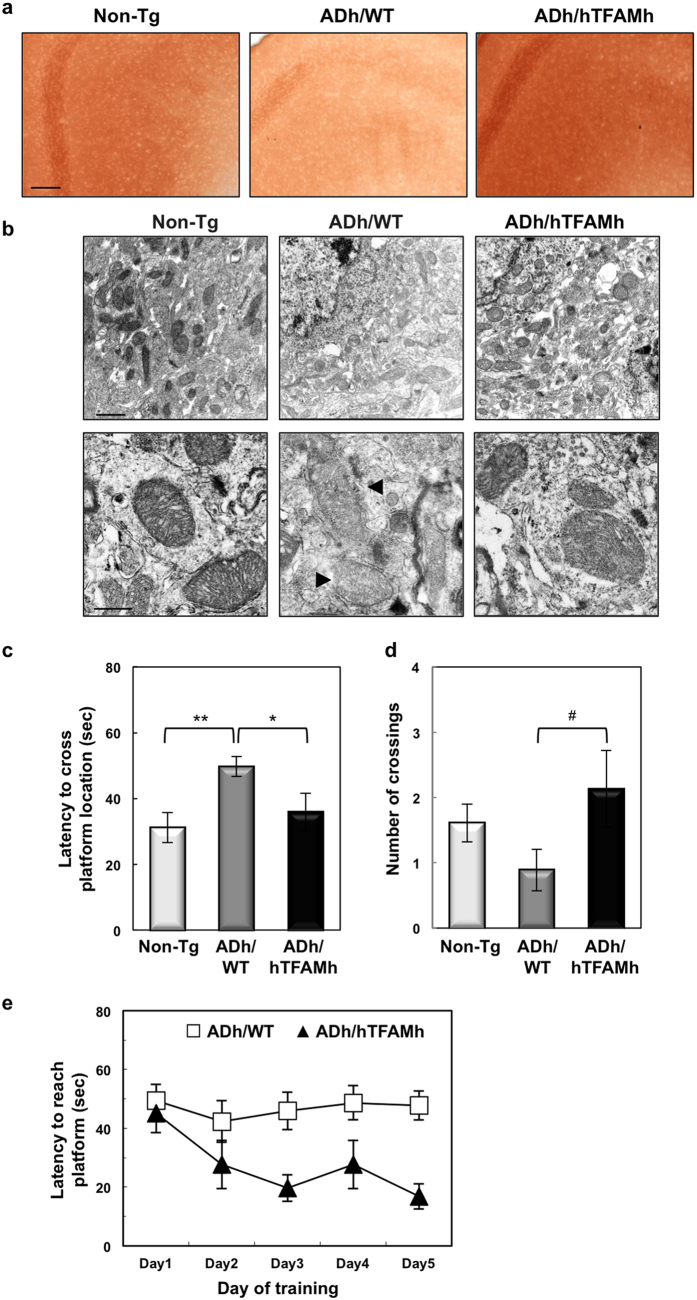
Expression of hTFAM improved mitochondrial function in the ADh/WT cerebral cortex and cognitive impairment in ADh/WT mice.(a) Expression of hTFAM improved mitochondrial function in the ADh/WT cerebral cortex. Mitochondrial function was determined by enzymatic staining for cytochrome c oxidase (COX). Frozen sections from the cortex of 13–14-month-old Non-Tg, ADh/WT, and ADh/hTFAMh mice were stained for COX (reddish brown). Scale bar, 20 μm. (b) COX enzymatic staining in each mitochondrion in the cortex was visualized by electron microscopy. Arrowheads show degenerating mitochondria characterized by diminished COX staining and disrupted membranes and cristae in the ADh/WT cortex. Scale bars, 1 μm (upper panels); 500 nm (lower panels). (c) Latency to cross over the previously hidden platform 24 h after the training trial in the d2 protocol of the Morris water maze using 11–12-month-old Non-Tg, ADh/WT, and ADh/hTFAMh mice. One-way ANOVA, p = 0.0076. Tukey’s HSD test (vs. ADh/WT), *p < 0.05, **p < 0.01. Data represent means ± SEM, n = 5–8. (d) The number of crossings over the previously hidden platform 24 h after the training trial in the d2 protocol of the Morris water maze using 11–12-month-old Non-Tg, ADh/WT, and ADh/hTFAMh mice. Student’s t-test (vs. ADh/WT), #p = 0.0463. Data represent means ± SEM, n = 5–8. (e) Latency to reach the platform in the d5 protocol of the Morris water maze using 11–12-month-old ADh/WT and ADh/hTFAMh mice. Multivariate analysis of variance (MANOVA), genotype, p = 0.0011. Data represent means ± SEM, n = 5–8.